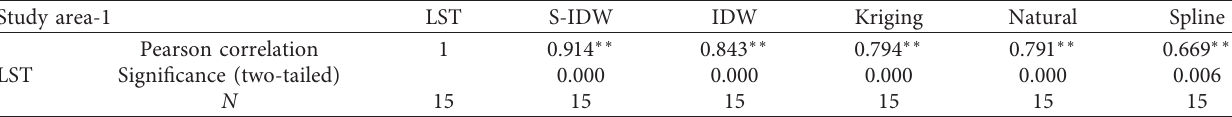
Table 11: Correlation analysis of interpolation results of 5 kinds of interpolation methods on Aug. 9, 2013. Study